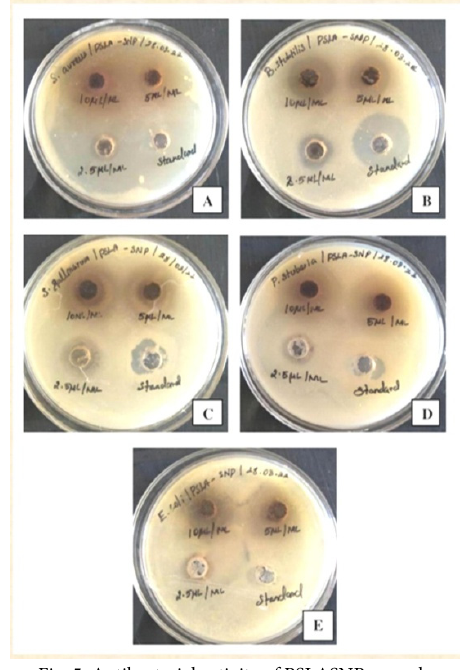
Fig. 5. Antibacterial activity of PSLASNPs sample